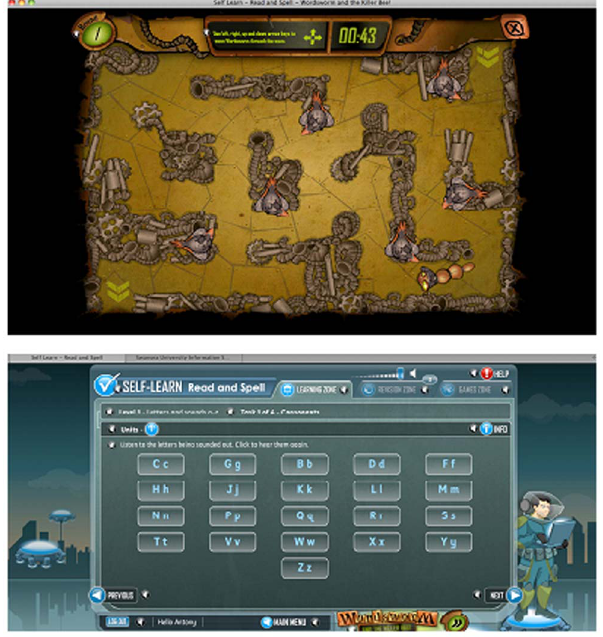
Figure 1. Screen shots of computer game used as a reinforcer (top panel), and part of the teaching programme (bottom panel).